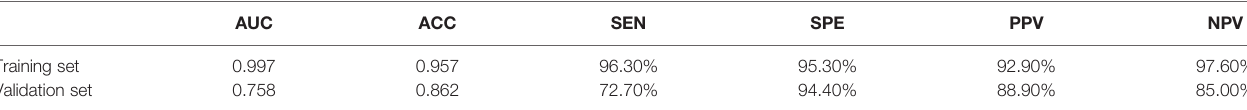
TABLE 2 | Performance of the MLP classi fi er in the training and validation sets.